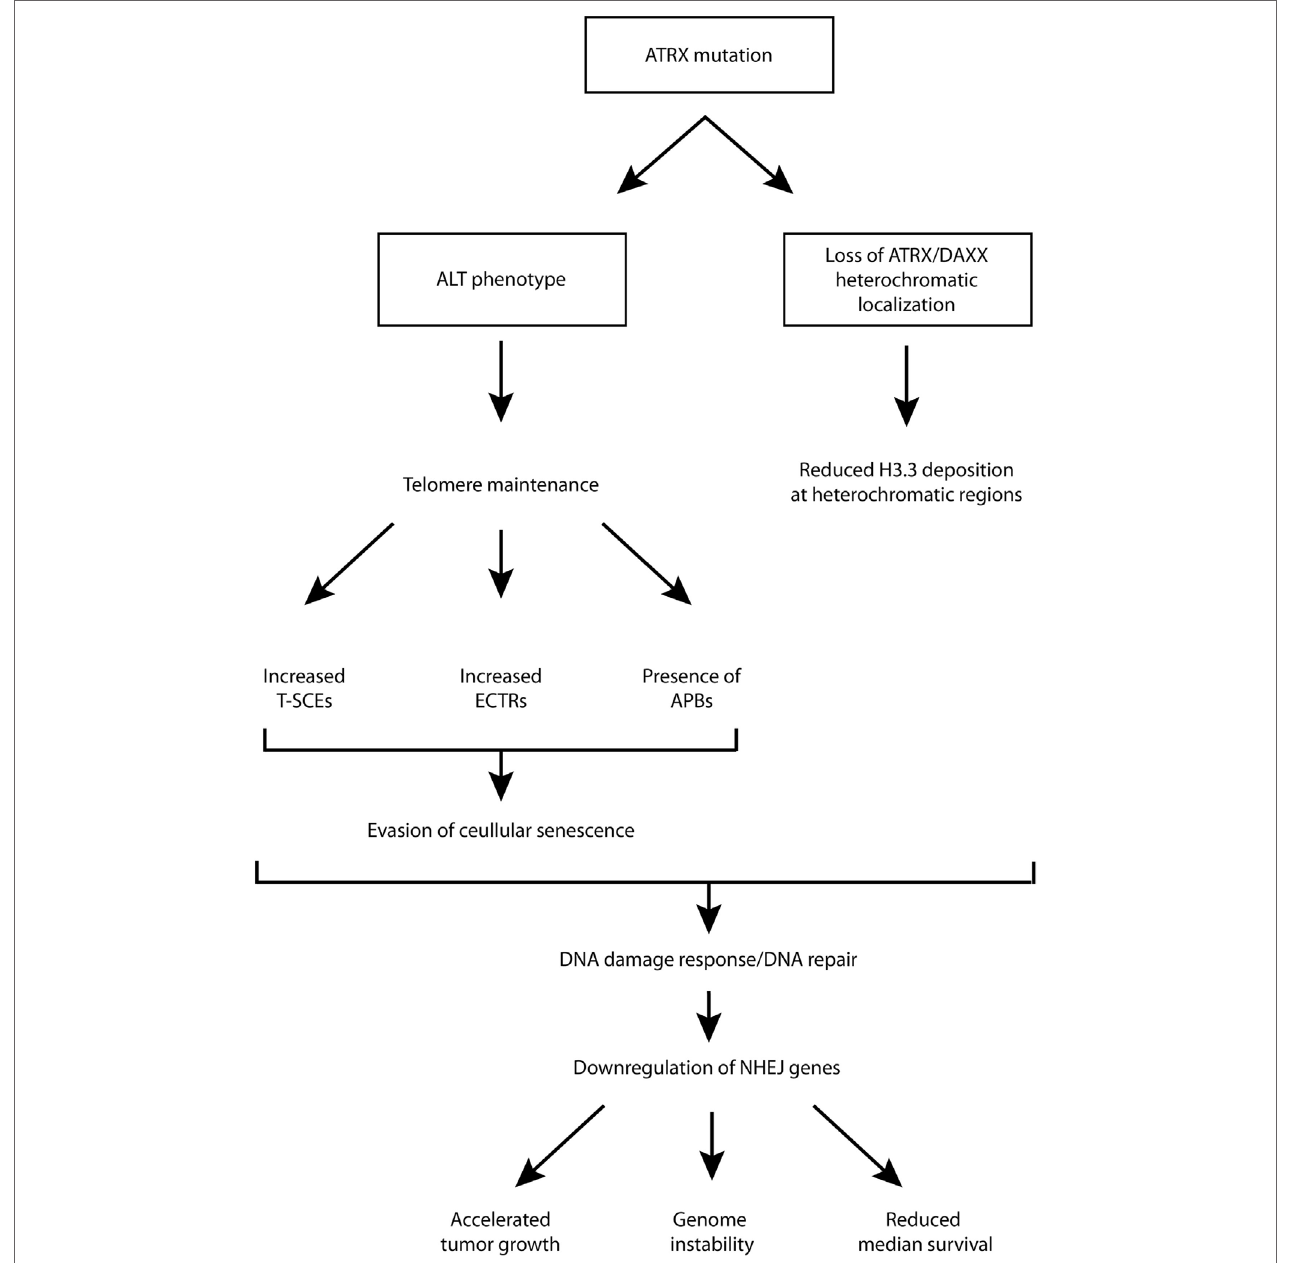
FiGURe 1 | Schematic diagram of putative downstream molecular and cellular events following ATRX mutation. ALT, alternative lengthening of telomeres; APB, ALT-associated promyelocytic leukemia bodies; ATRX, alpha thalassemia/mental retardation syndrome X-linked; DAXX, death domain-associated protein; ECTR, extrachromosomal telomeric repeat; NHEJ, non-homologous end joining; T-SCE, telomere sister chromatid